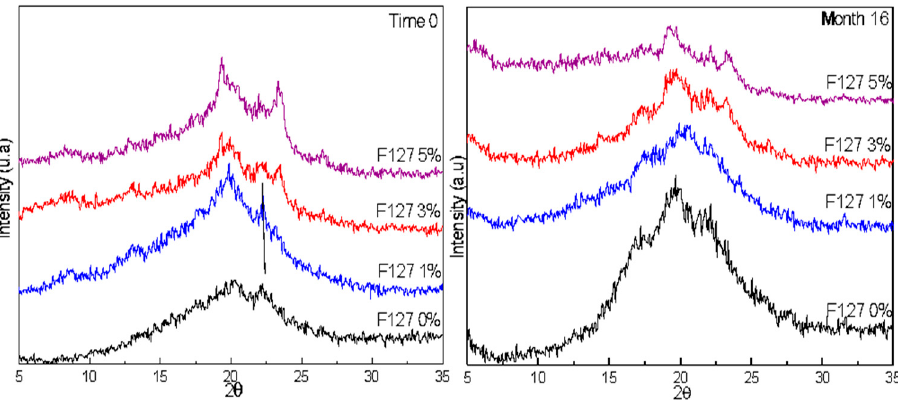
Figure 4. X-ray diffraction patterns of biodegradable films of corn starch-chitosan with pluronic F127 at ratios of 0%, 1%, 3%, and 5% stored for 0 and 16 months. Table 2. DSC parameters of biodegradable films of corn starch-chitosan with pluronic F127 at ratios of 0%, 1%, 3%, and 5% stored for 0 and 16